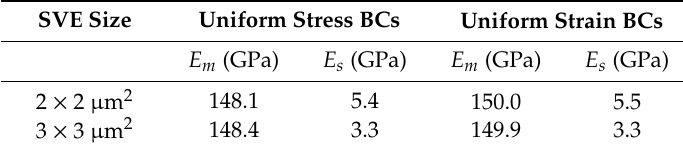
Table 1. Stochastic homogenization: e ff ect of the SVE size on the mean E m and standard deviation E s of the scattered in-plane polysilicon Young’s modulus. SVE size uniform stress BCs uniform strain BCs 𝐸 (cid:3040) 𝐸 (cid:3046) 𝐸 (cid:3040) (GPa) (GPa) (GPa)